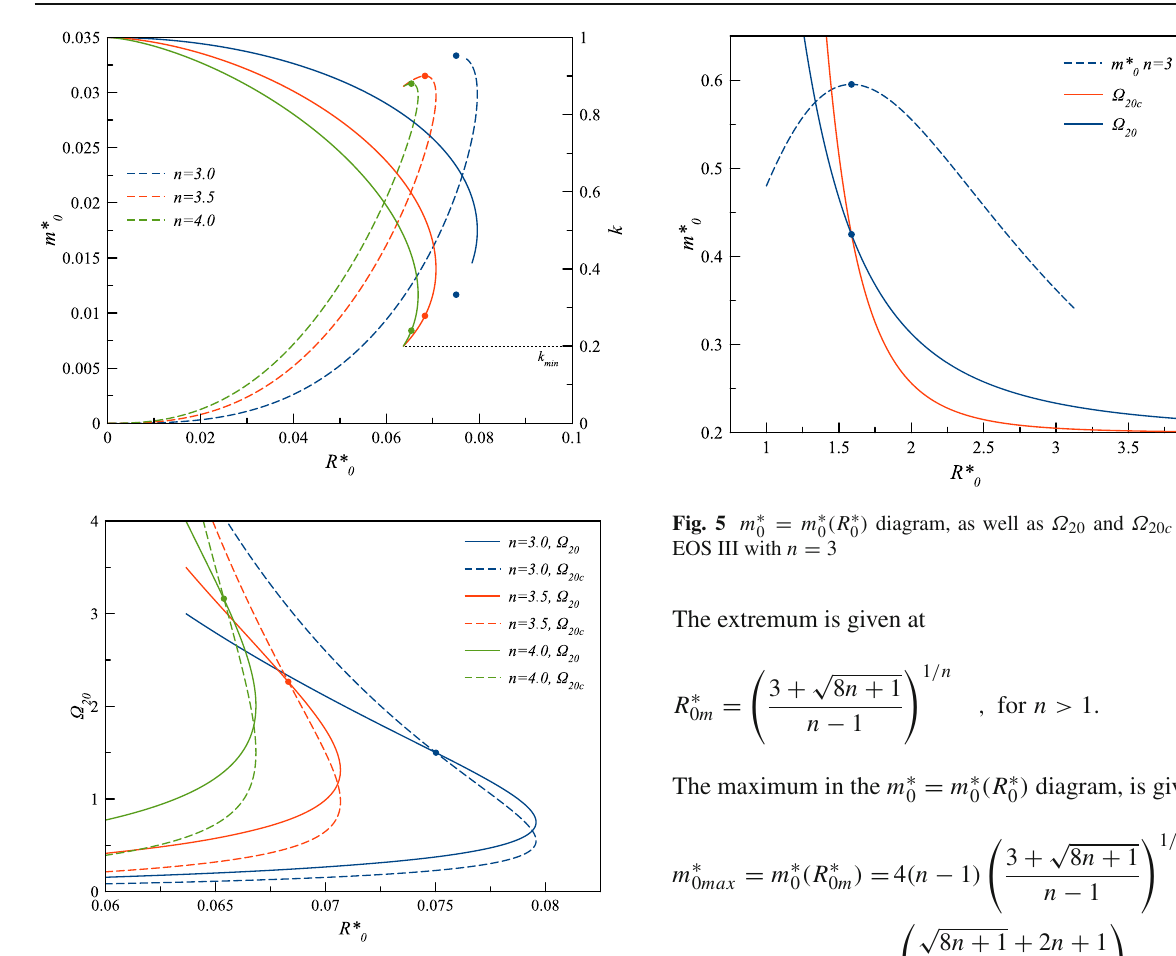
= m ∗ ( R ∗ ) (dashed line) and k = k ( R ∗ Fig. 4 Upper panel: m ∗ 0 0 0 curves (full line) for EOS II and several values of n . k min = 1 / 5 is the smallest value of k which satisfies the DEC. Lower panel: plots of Ω 20 and Ω 20 c in terms of R ∗ for different values of n in EOS II. Regarding 0 m ∗ and Ω 20 , note that the value of the R ∗ coordinate of each of the 0 0 coloured dots in the upper and lower panels is the same